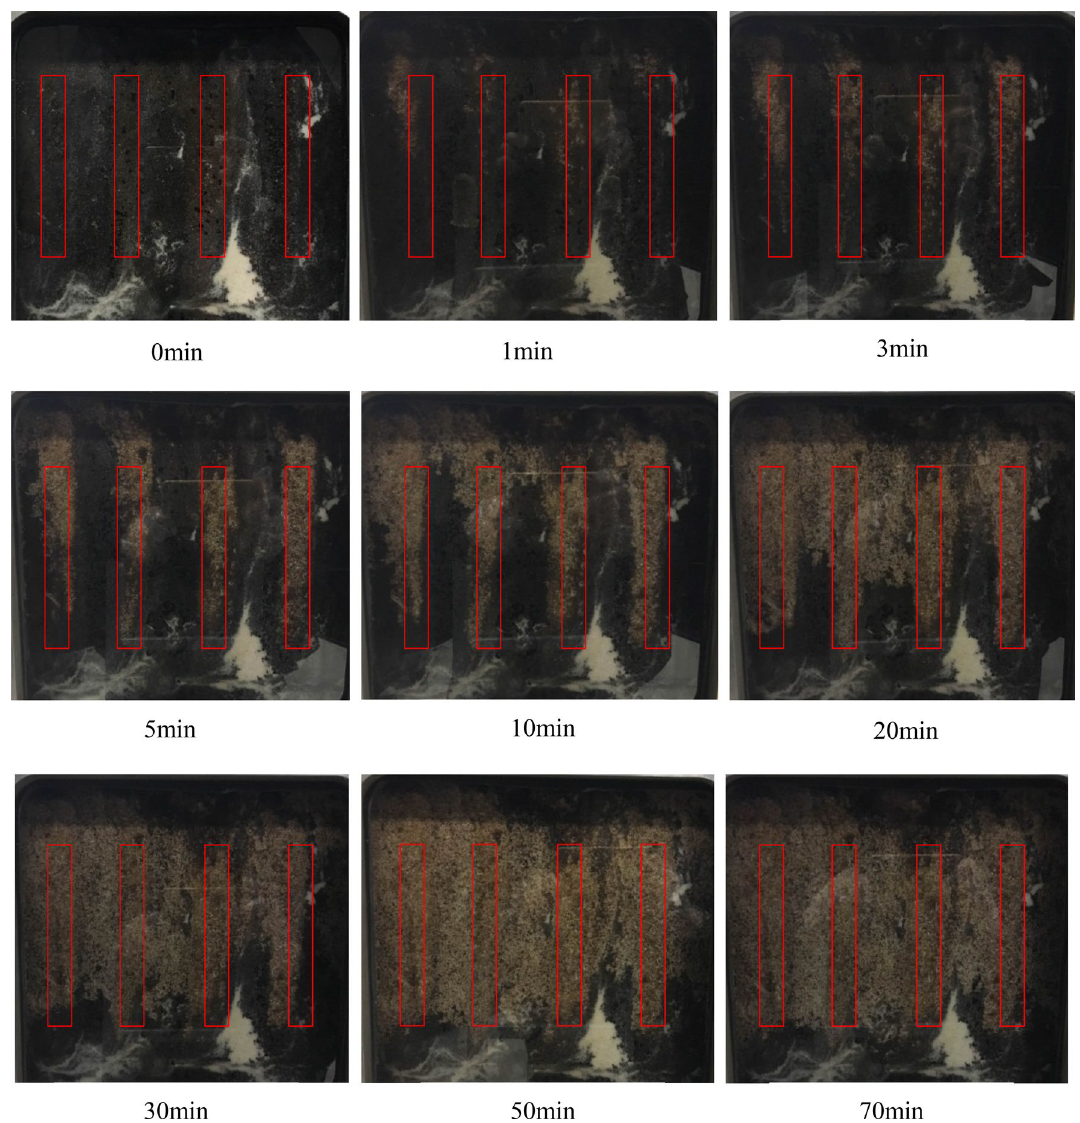
Fig. 9 Distribution of remaining oil in the different production processes of nitrogen and nitrogen foam-assisted gravity